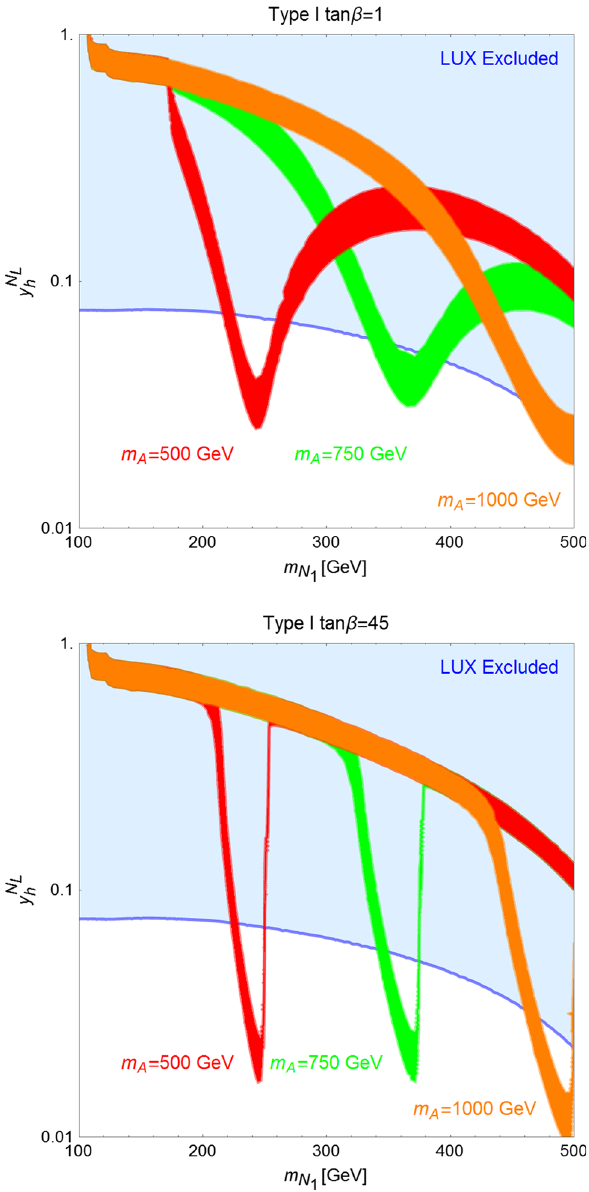
Fig. 8 IsocontoursofthecorrectDMrelicdensityinthebidimensional , y N L ) for two values of tan β , ( upper panel ) 1 and ( lower plane ( m N h 1 panel ) 45, and for the following assignations of the other parameters = y E R = 0, y E L = 0 . 5, y N L = − y N R = of the fermion sector: y N R h h h H H = y E R = 1. We have finally set M = m = m = m − y E L H A H ± and H H considered the three values of 500 GeV, 750 GeV and 1 TeV